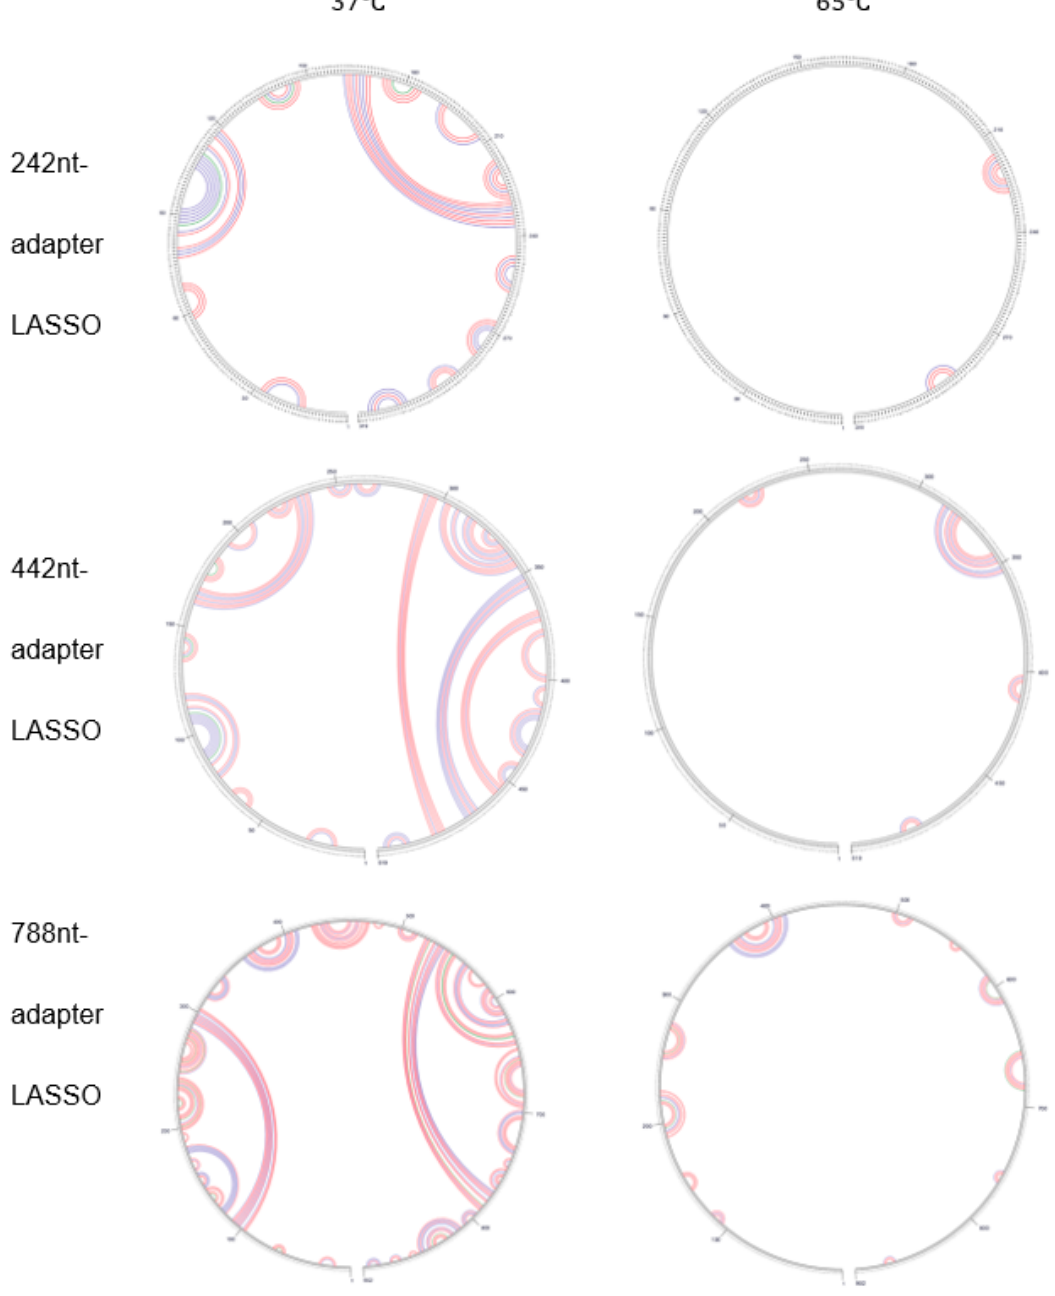
Figure 3. Circle graphs of secondary structure predicted by Mfold [14] for LASSO probes designed to capture the E. coli gene nemR at 37 ◦ C and 65 ◦ C. Bases are drawn along the circumference of the circle. The arcs inside the circles denote the base pairs predicted by Mfold to contribute to the secondary structure of the probe. The red arcs correspond to the predicted G—C pairs, the blue arcs to the A—T pairs and the green arcs to the G—T pairs.